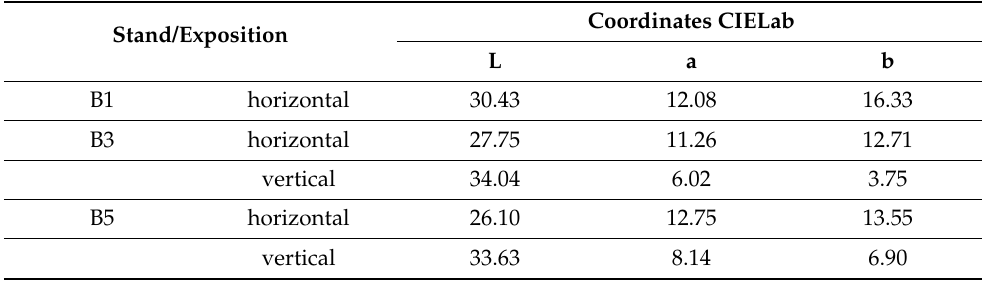
Table 23. Colorimetric parameters of exposed samples.